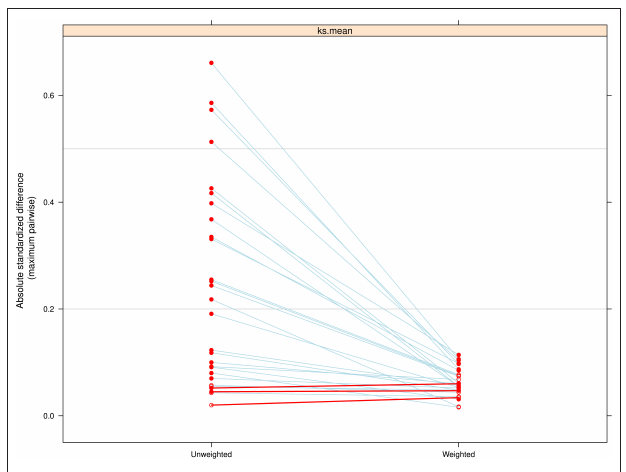
FIGURE 1 | Comparison of the absolute standardized mean difference (ASMD) between treatment groups (levels of breastfeeding duration) on pretreatment covariates, before and after weighting. The weighting was successful in reducing imbalance across all covariates included in the model except for three that had a slight decrease in